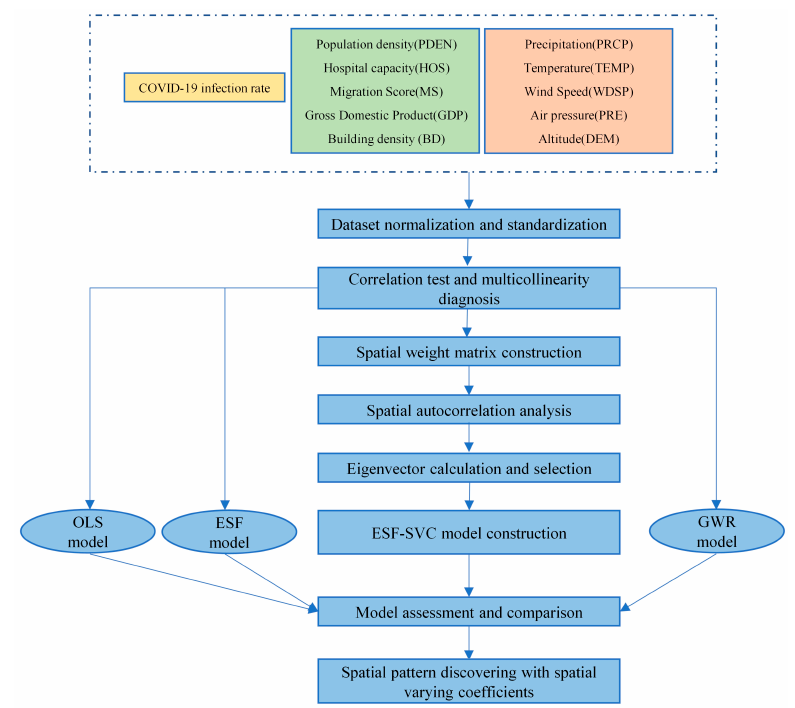
Figure 2. Flowchart of research method and experimental procedures.